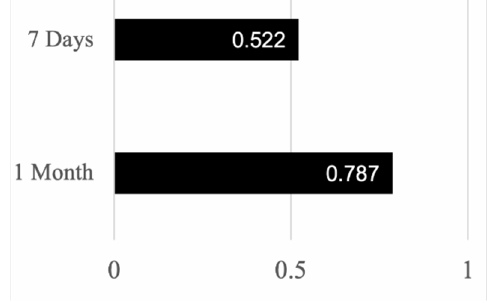
Figure 17. Correlation r with annual turnover.